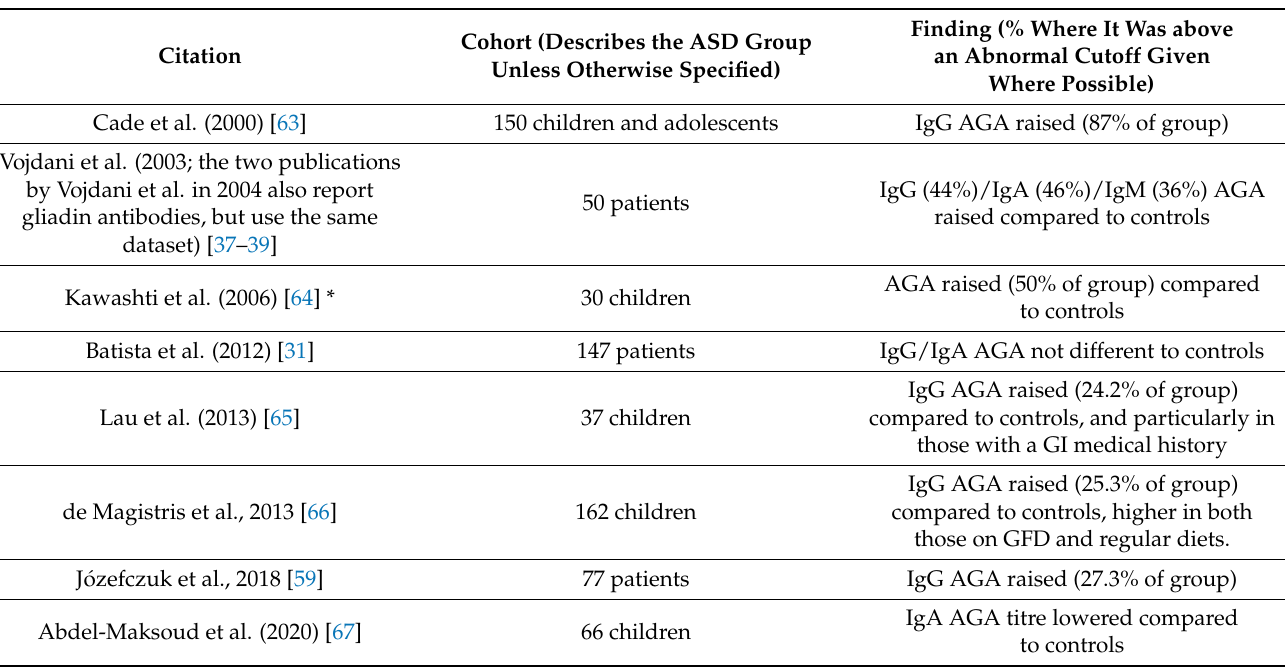
Table 1. A summary of studies which have investigated if gliadin antibodies (AGA) are affected by ASD. * : full text not